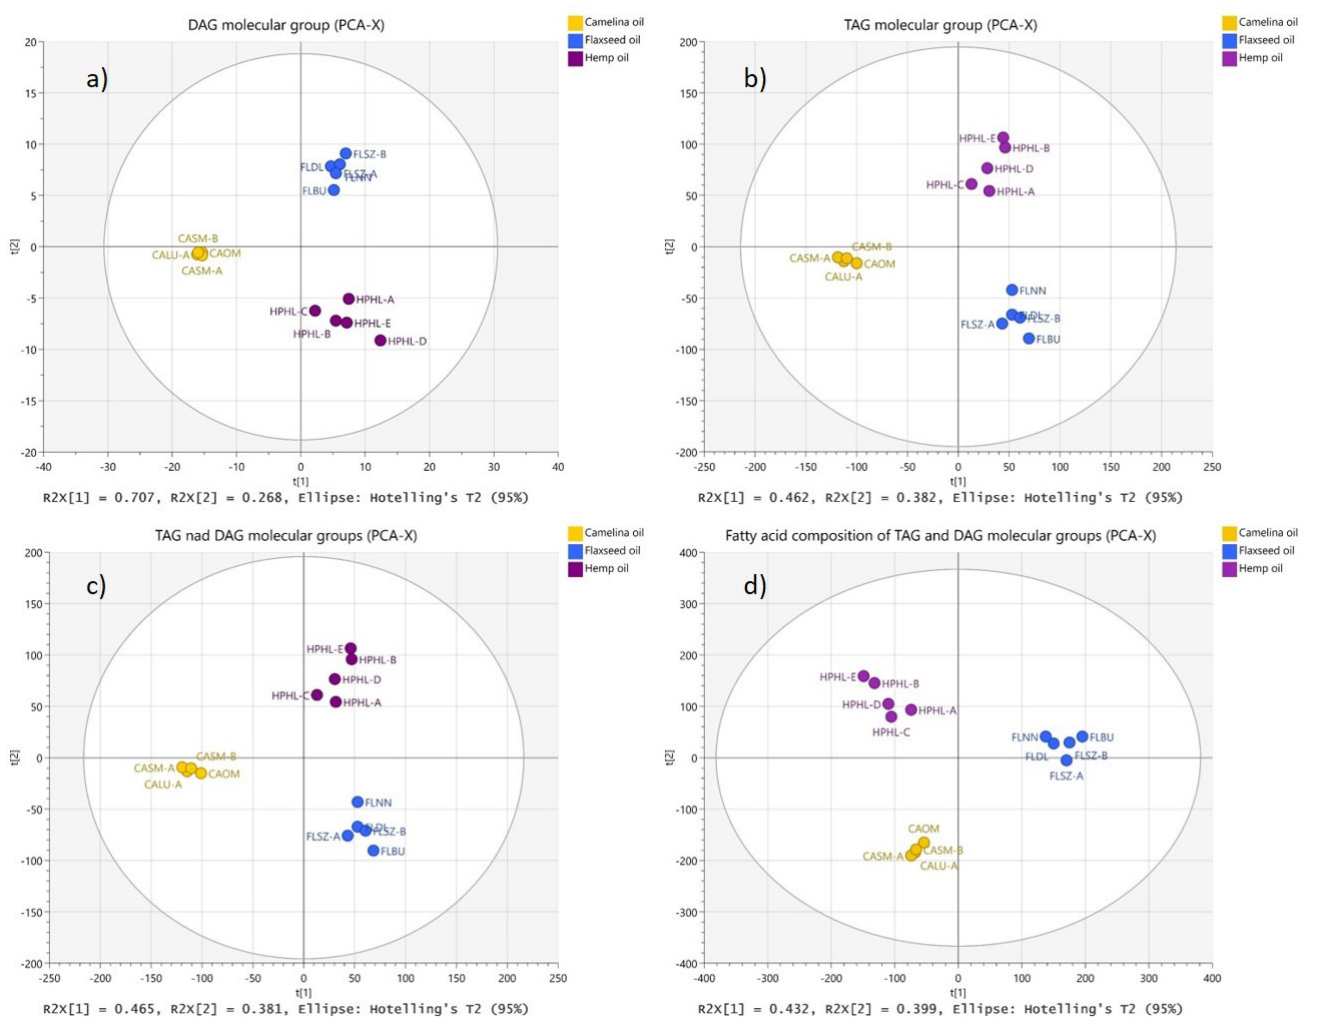
Figure 2. PCA score plots of the oil lipid composition data: ( a ) DAG molecular groups (principal component explained variance (PC %EV) = 97.5%; ( b ) TAG molecular groups (PC %EV = 84.4%; ( c ) TAG and DAG molecular groups (PC %EV =84.6%; ( d ) FA content in DAG and TAGs (PC %EV = 83.1%).